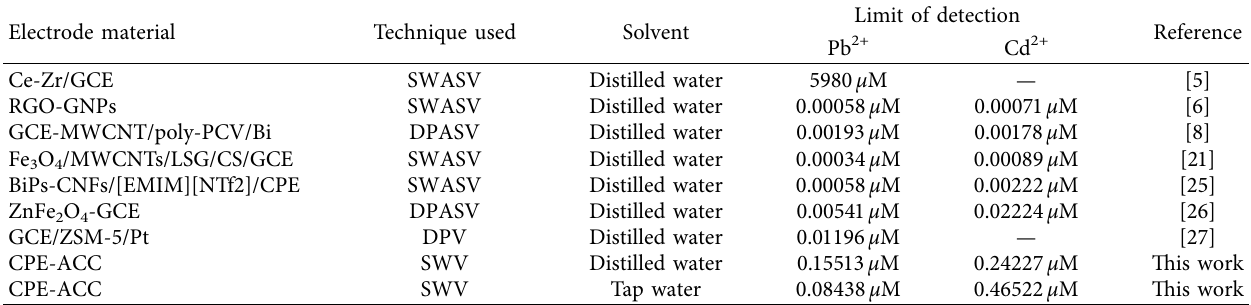
Table 1: Comparison of the performance of some electrodes with other analytical methods for lead and